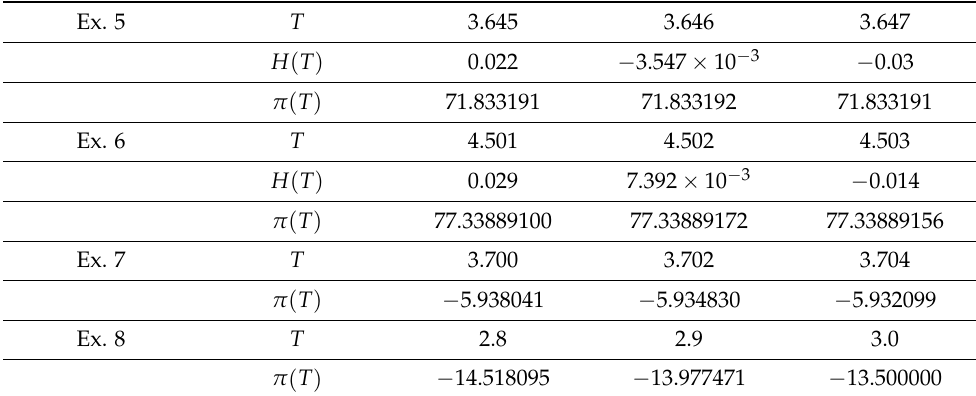
Table 8. Comparisons near the optimal solution for Examples